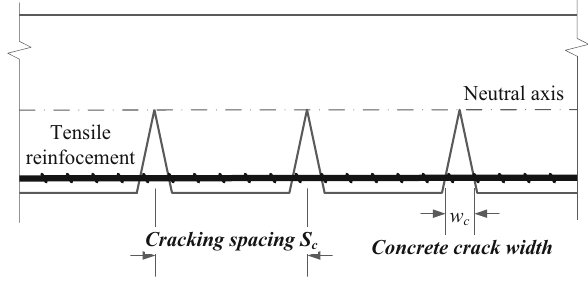
Fig. 1 Model of the flexural crack width in ACI 318.